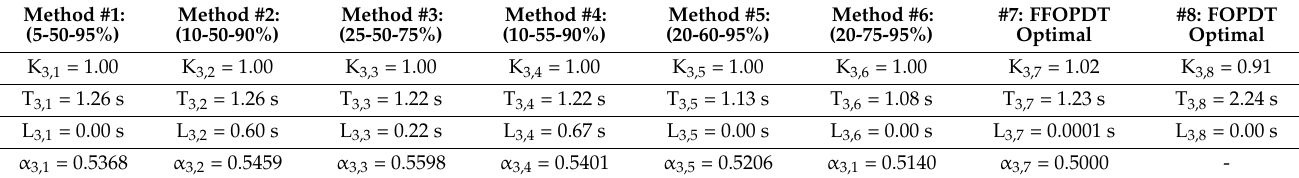
Table 21. Fractional-order model settings for the symmetrical and asymmetrical sets of points (5-50- 95%), (10-50-90%), (25-50-75%), (10-55-90%), (20-60-95%), and (20-75-95%), respectively, and optimal FFOPDT and FOPDT model